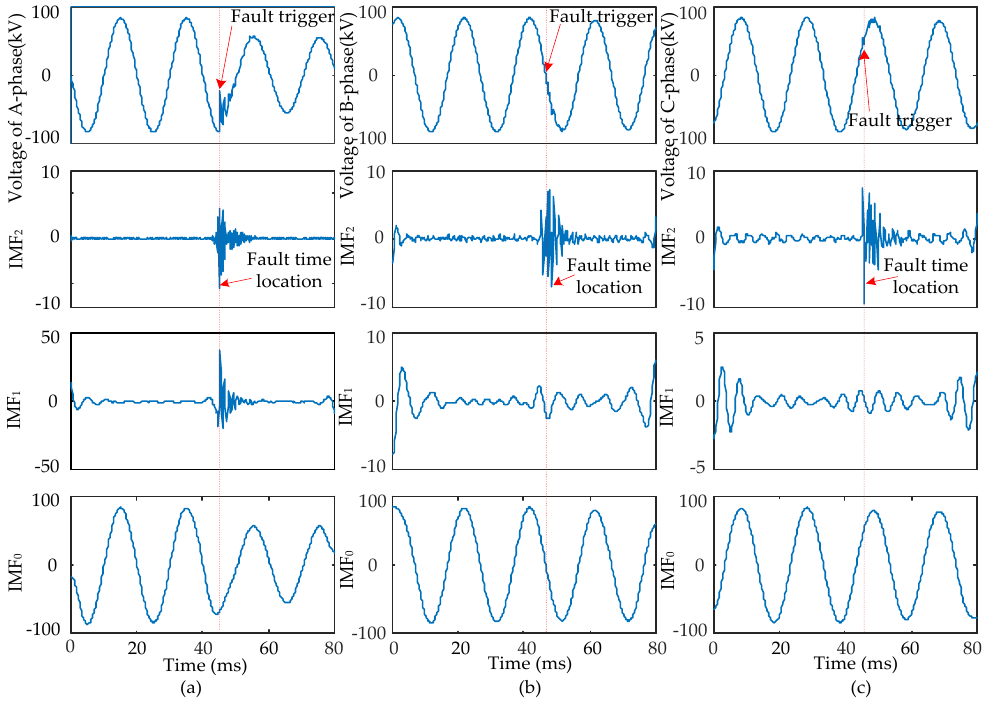
Figure 13. Actual AG fault signal’s modes extracted by the EWT are shown as follows: ( a ) A-phase voltage and its IMFs; ( b ) B-phase voltage and its IMFs; ( c ) C-phase voltage and its IMFs.